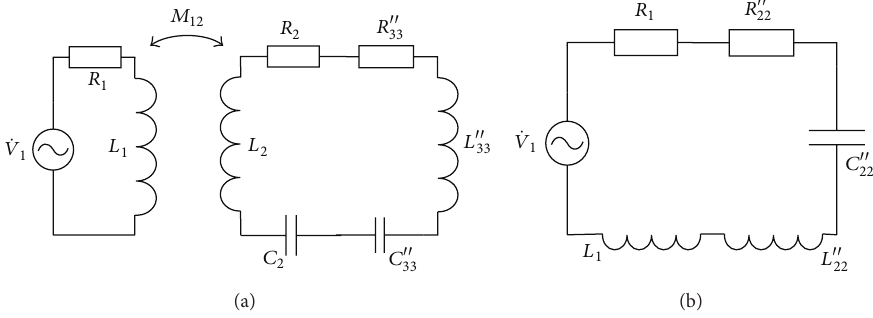
Figure 3: Mapping process for the resonant